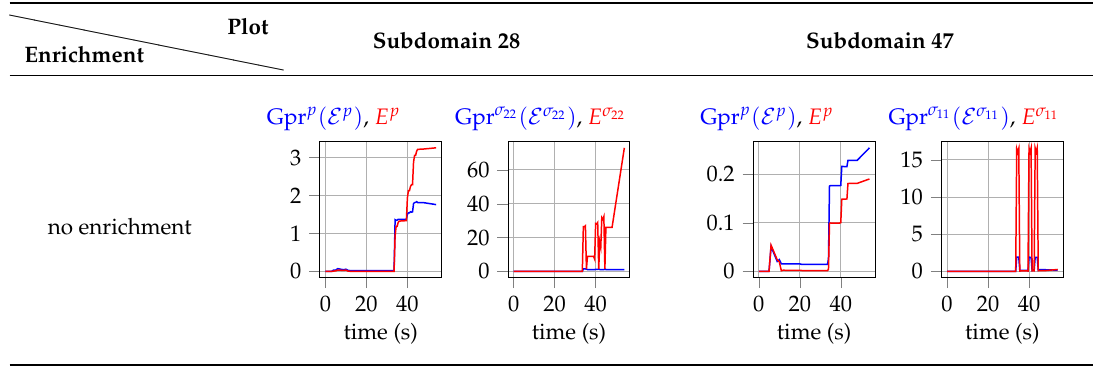
Table 8. Comparison of the error indicator (19) with the error (12) for the considered offline and online variabilities. The category “plot” for the columns refers to the subdomain for which the error indicator and the error are plotted, whereas the category “enrichment” for the rows refers to the subdomain of whom the indicator is used to decide the enrichment